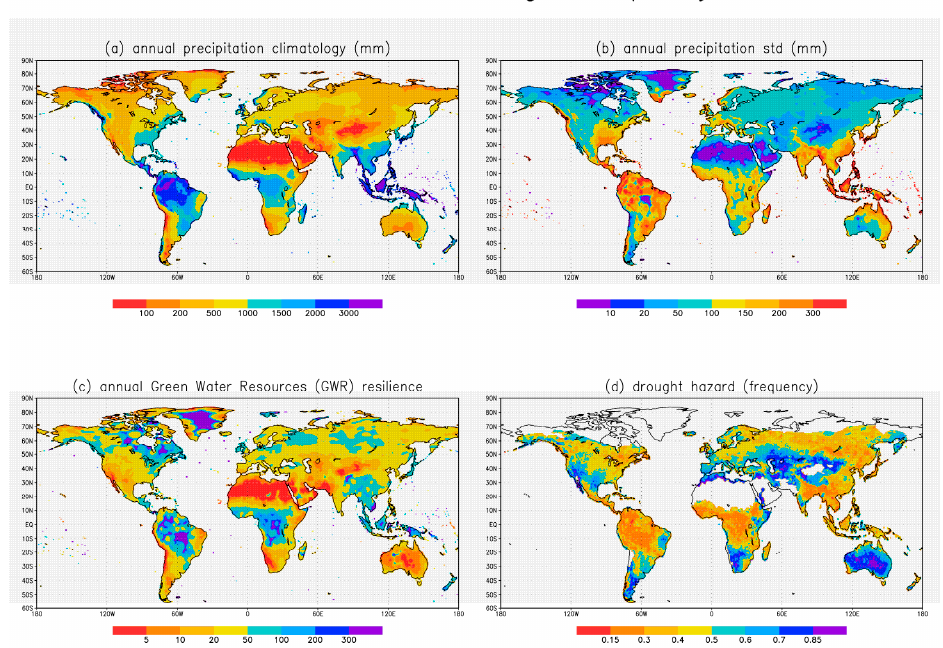
Figure 1. Analysis of annual mean precipitation observed data for the period 1901–2015: ( a ) long-term climatology; ( b ) standard deviation; ( c ) annual green water resources resilience indicator ( R P ); ( d ) drought hazard computed independently with the Weighted Anomaly of Standardized Precipitation Index (WASP; [28,29]).